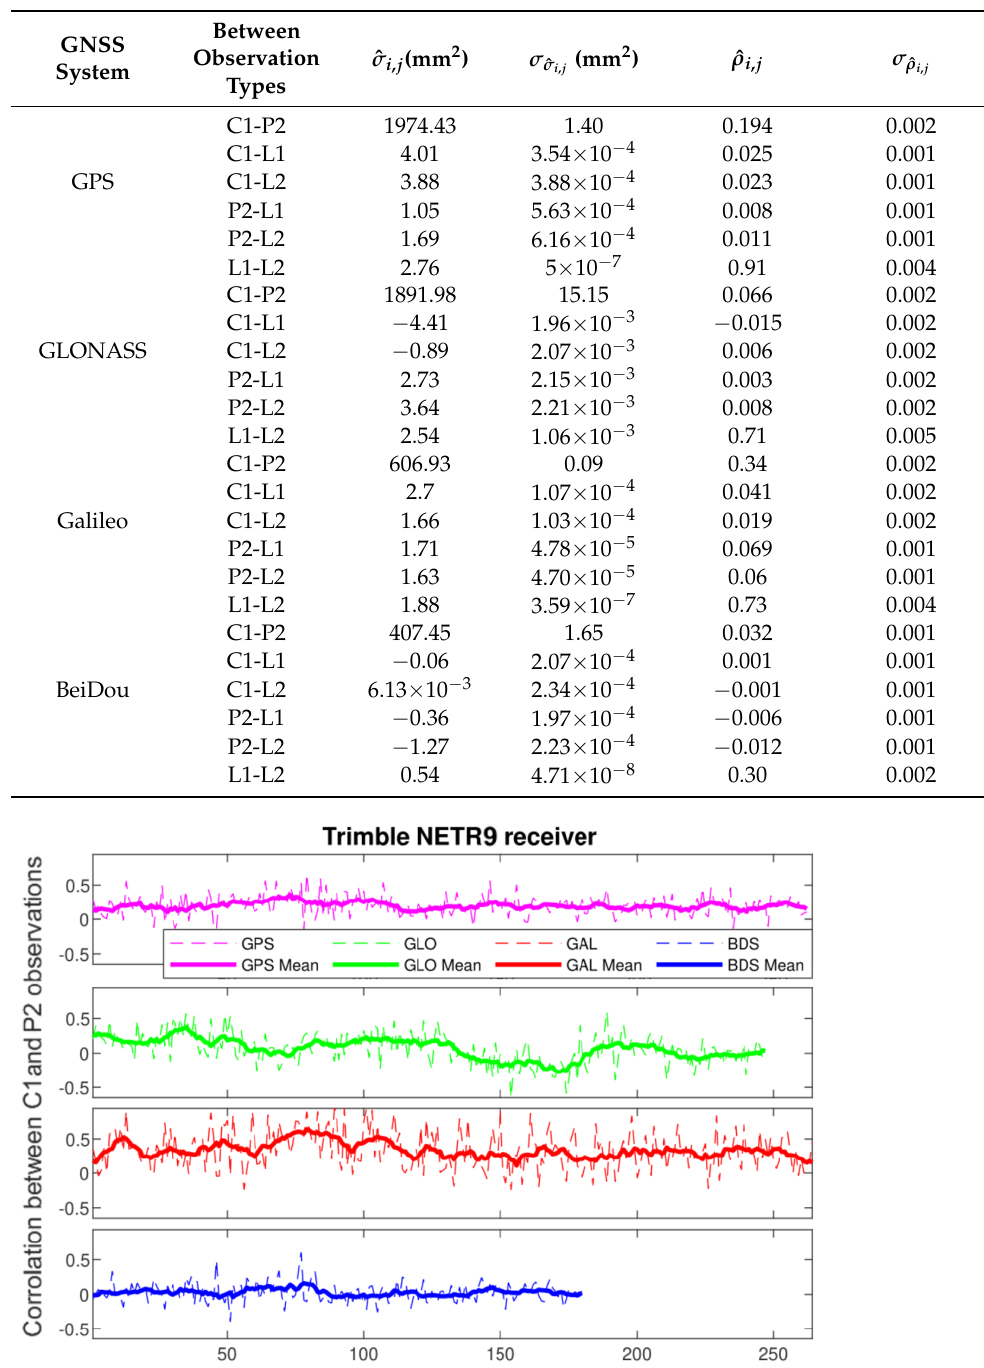
Table 5. Covariances and correlation coefficient and their precision between the observation types for each system for the Trimble NETR9 receiver over a zero baseline.